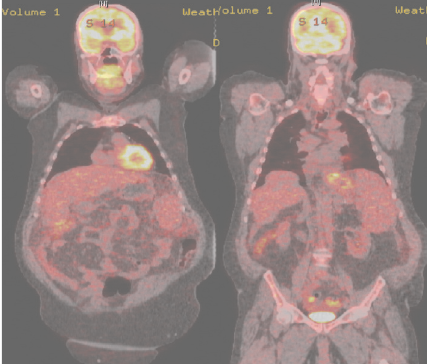
Figure 2: PET CT scan showing the absence of focal FDG uptake, in addition to stigmata of liver